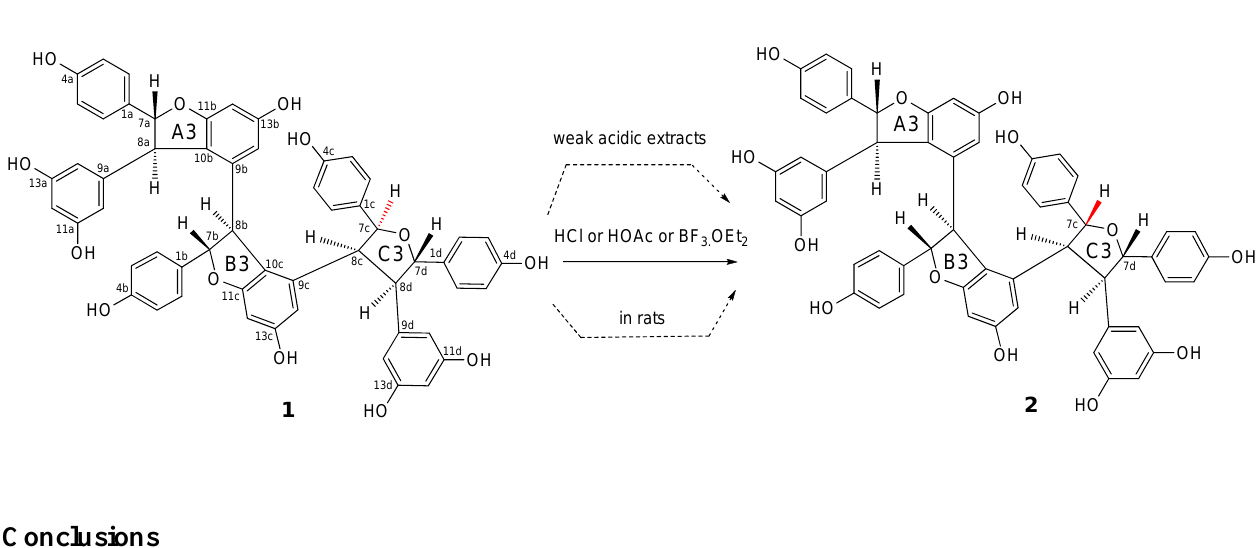
Figure 2 . Conversion from 1 to 2